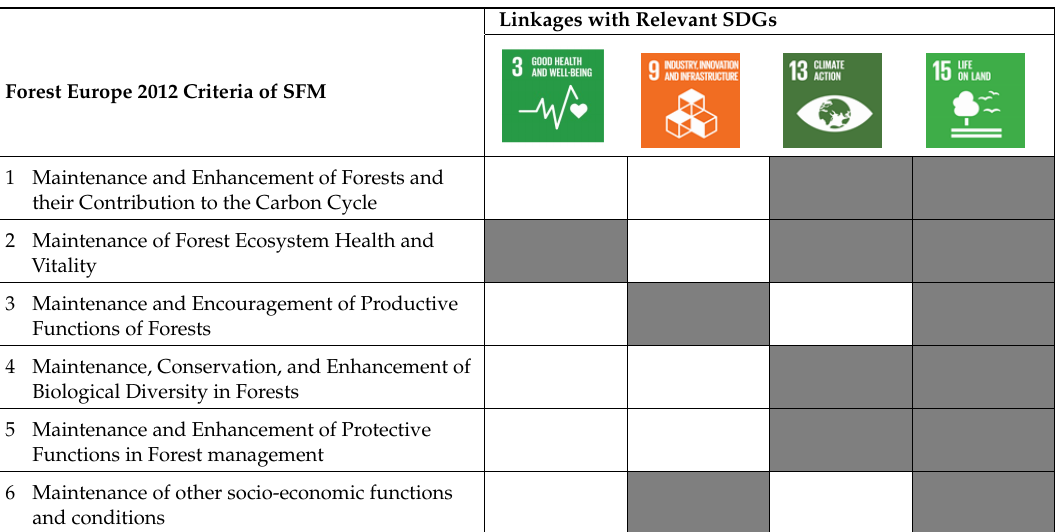
Table 1. Criteria for sustainable forest management (SFM) from Forest Europe (2016) [19] and their linkages with the Sustainable Development Goals (SDGs) marked in